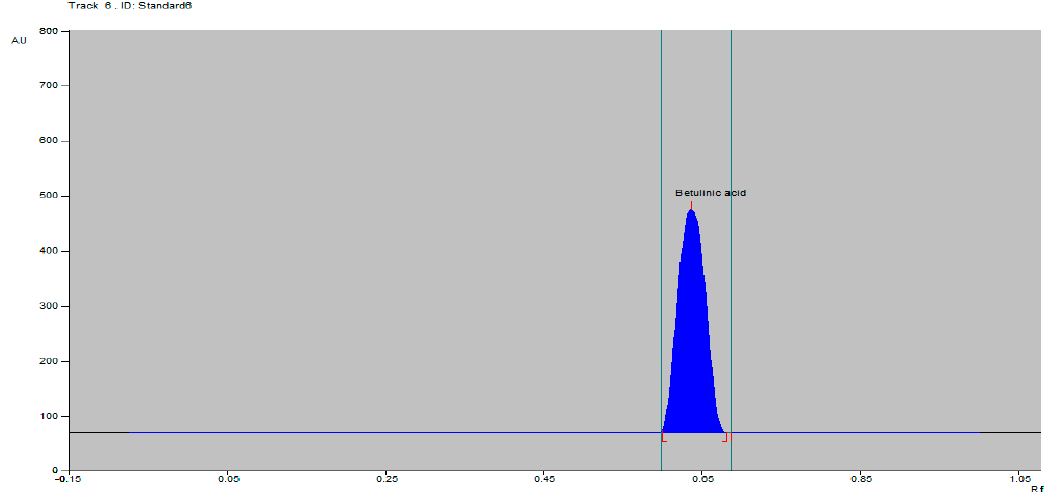
Figure 2. HPTLC chromatogram of BA standard.